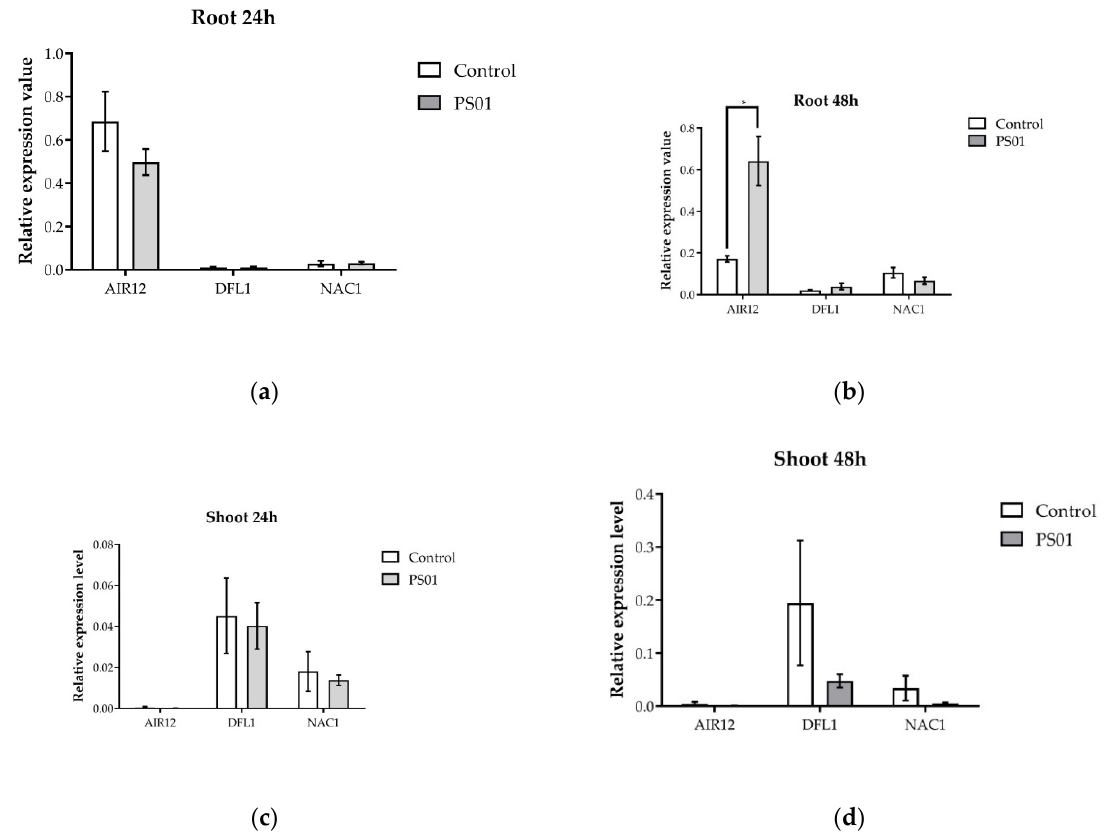
Figure 6. E ff ect of inoculation with PS01 on the expression levels of genes involved in auxin-dependent lateral root development regulation in Arabidopsis ( AIR12 , DFL1 , NAC1 ) (Table S1). RT-PCR analyses of gene expression have been performed separately on root ( a , b ) and shoot ( c , d ) at 24 and 48 h after inoculation. The bars presented are the mean expression levels ± SD ( n = 3). Gene expression was normalized to Actin (At3 g18780) expression level. Asterisks indicate significant di ff erences (Student’s t test; p < 0.05).